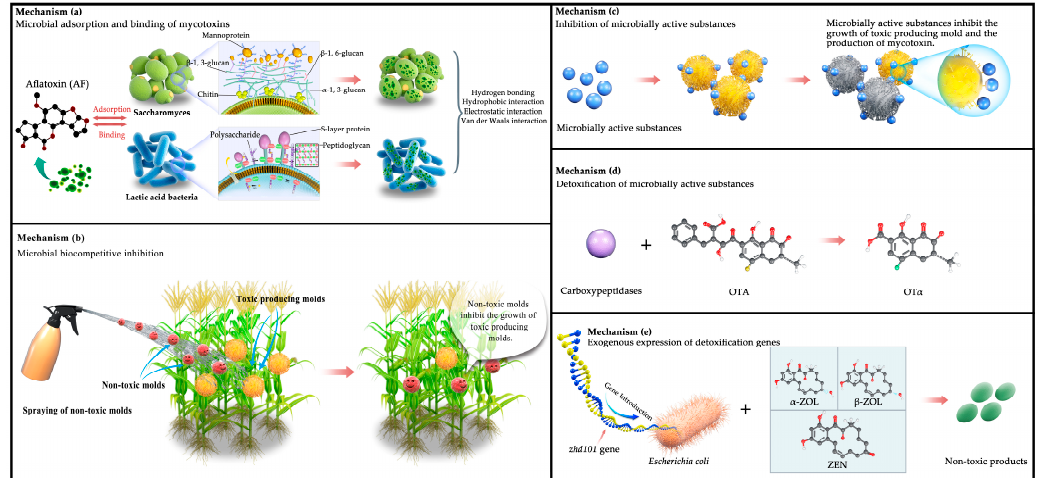
Figure 2. Mechanisms of mycotoxin reduction. ( a ) Microbial adsorption and binding of mycotoxins; ( b ) microbial biocompetitive inhibition; ( c ) inhibition of microbially active substances; ( d ) detoxification of microbially active substances; ( e ) exogenous expression of detoxi fi cation genes. (Source: our own study).